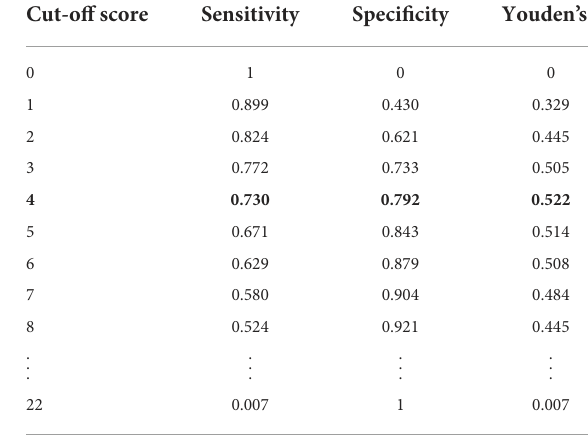
TABLE 3 Sensitivity, specificity for each cut-off